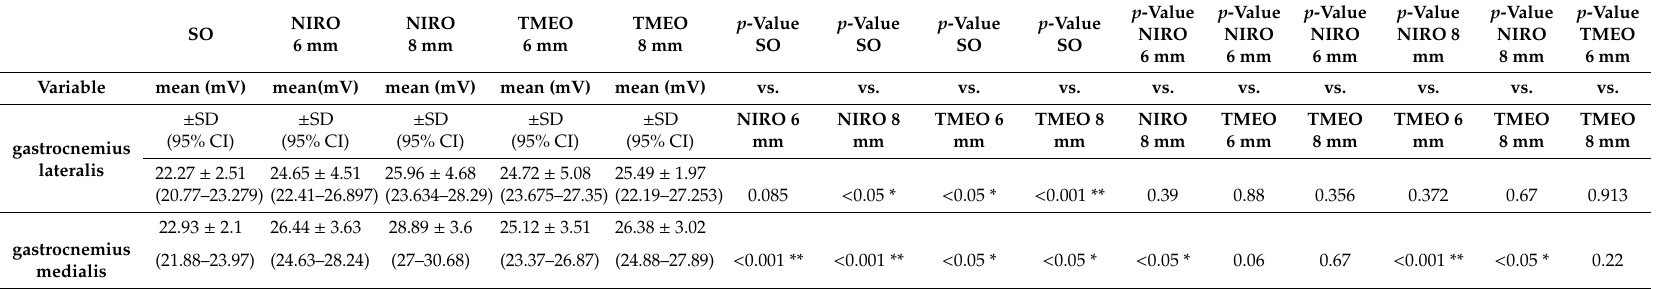
Table 3. Signal amplitudes and comparison values of the mean gastrocnemius lateralis and medialis muscle activities.